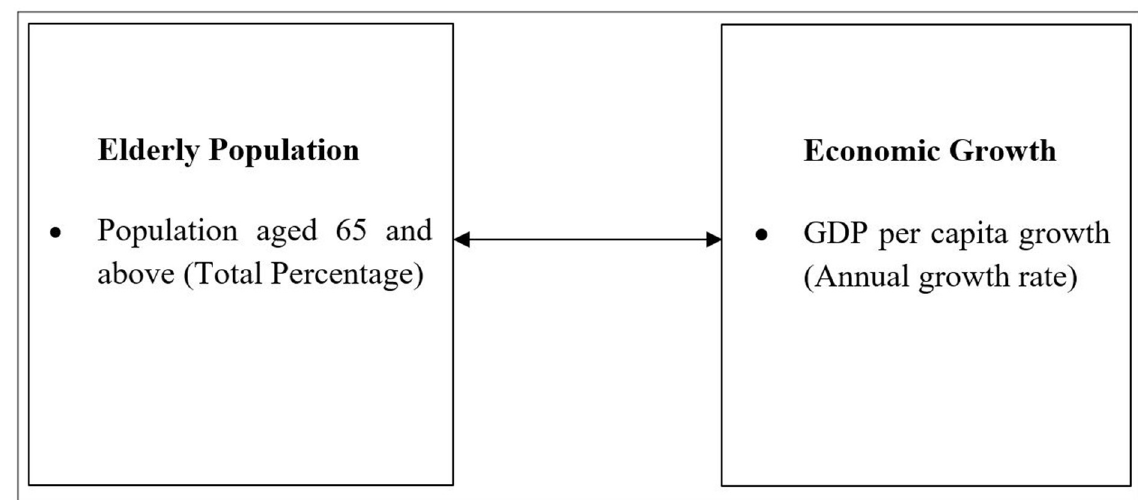
Fig 1. Theoretical framework of the research study. Source: Authors’ illustration based on past literature.